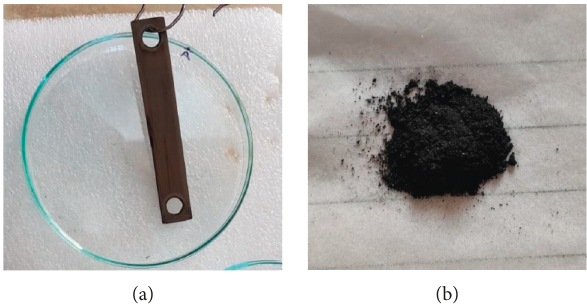
Figure 3: (a) Hard deposit on the coupon before scraping. (b) Hard deposit after scraping (obtained at 275 ° C, 100 RPM, after 80 hours of test run).